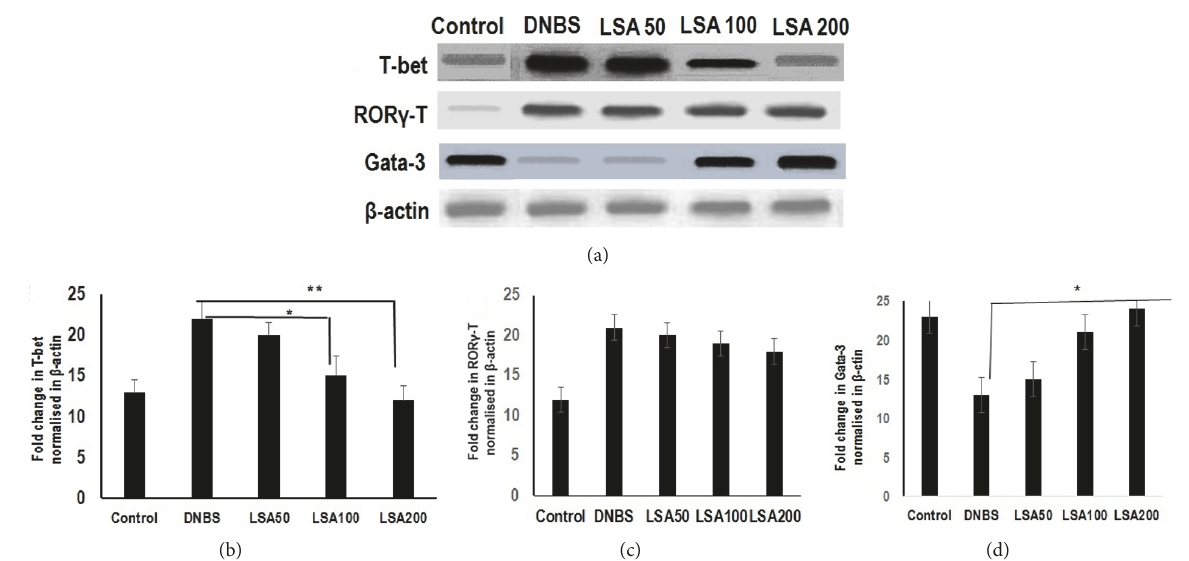
Figure 5: Relative gene expression of T-bet, ROR 𝛾 -T, and Gata-3 from the colon of CAC models. Amplification was performed by gene- specific primers with 2 𝜇 L cDNA for 25 cycles ( 𝛽 -actin) or 35 cycles (transcription factor). (b) The fold change in T-bet mRNA (normalized to 𝛽 -actin) expression in colon. (c) The fold change in ROR 𝛾− T mRNA (normalized to 𝛽 -actin) expression in colon. (d) The fold change in Gata-3 mRNA (normalized to 𝛽 -actin) expression in colon. Results shown are mean ± SD, with n=4 replicates in each group. ∗ p < 0.05. ∗∗ p < 0.001 (ns: not significant). Relative gene expression of p53 from the colon of CAC models. RNA was extracted from colons, and p53 gene expression was analyzed by real time PCR and normalized by 𝛽 -actin mRNA. Results are representative of four independent experiments. Data with no statistically significant differences (ns: not